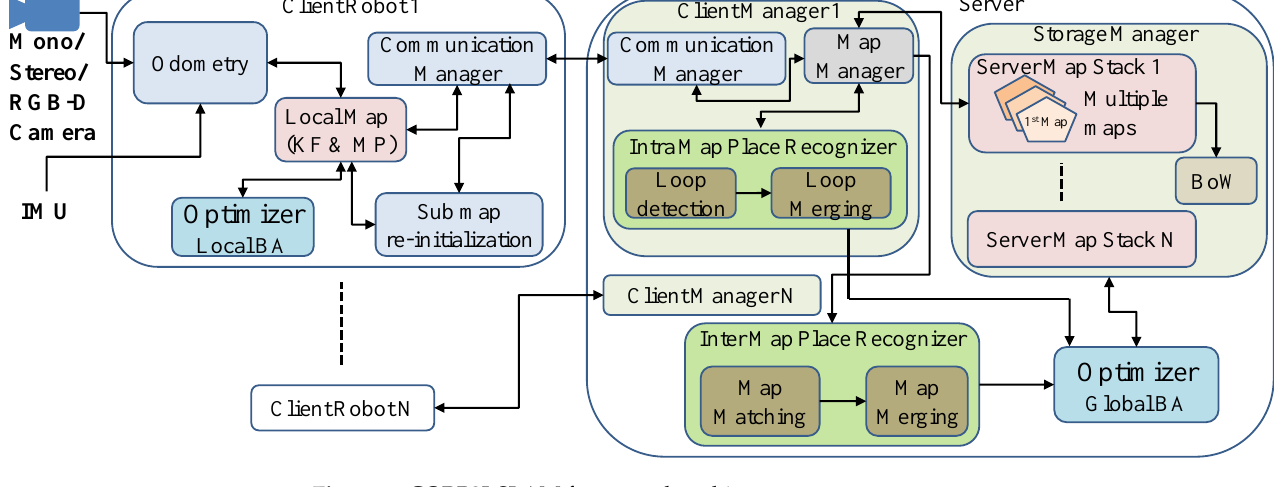
Figure 1. CORB2I-SLAM framework